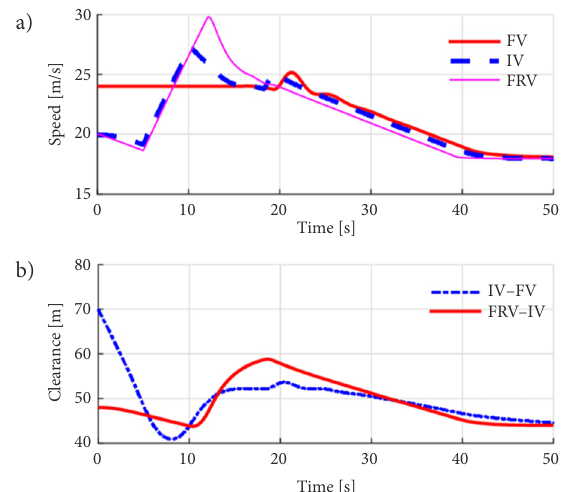
Figure 11. Speeds and clearances of vehicles considering rear-end collision escape with a low friction coefficient (source: created by the authors): a – speeds of vehicles; b – clearances between vehicles; FV – following vehicle; IV – intelligent vehicle; FRV –